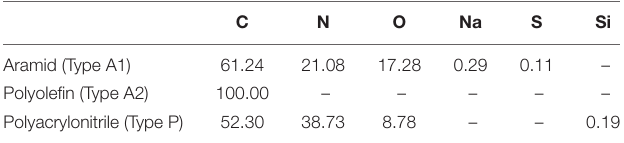
TABLE 2 | Elemental analysis (atom%) of the fibers. TABLE 3 | Bitumen properties before and after mixing and extraction processes.